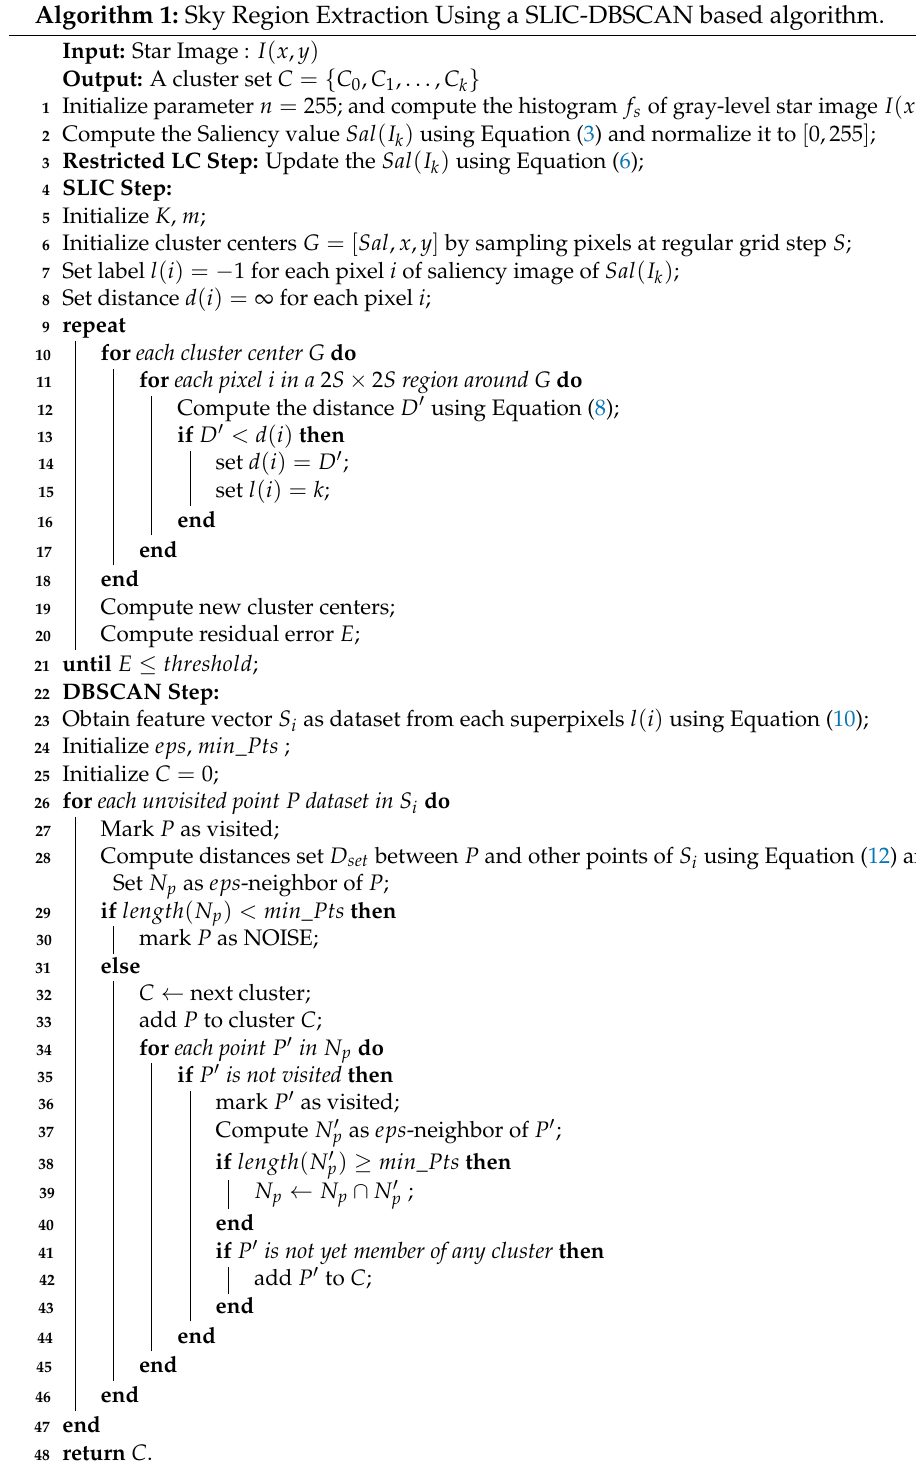
Algorithm 1: Sky Region Extraction Using a SLIC-DBSCAN based